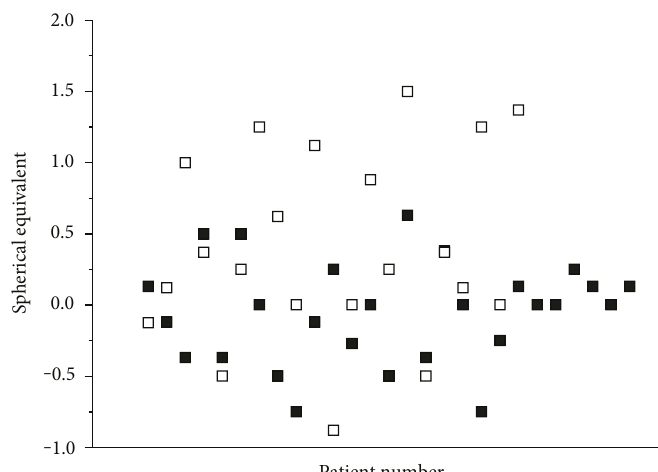
Figure 3: Refractive outcome in patients undergoing phacoemulsi fi cation before trabeculectomy (group A, n = 21 , open squares) and in patients undergoing trabeculectomy before phacoemulsi fi cation (group B, n = 27 , solid squares). A signi fi cant di ff erence was observed in spherical equivalent between the groups ( p = 0 018